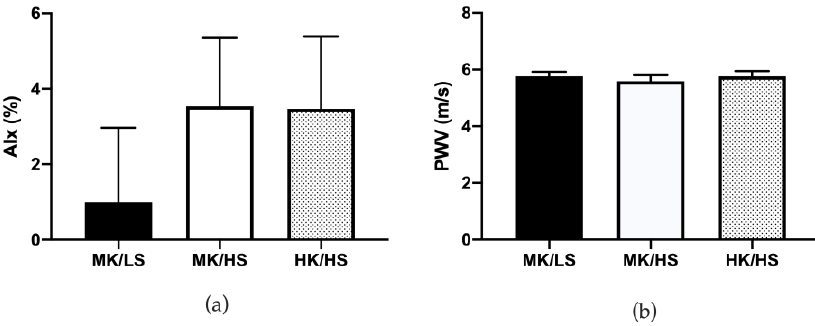
Figure 4. ( a ) Augmentation index (AIx) was unaltered over the three diets. ( b ) Pulse wave velocity (PWV) remained unchanged over the three diets. Values are mean ± SE. HK/HS, high potassium/high sodium; MK/HS, moderate potassium/high sodium; MK/LS, moderate potassium/low sodium.